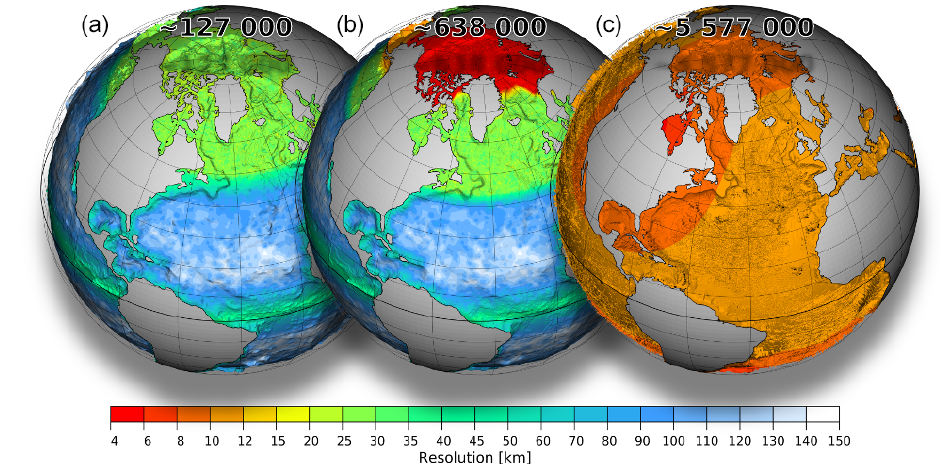
Figure 1. Resolution maps for meshes used for our experiments: CORE2 (a) , fArc (b) , and STORM (c) . Total number of surface vertices for each mesh is displayed at the